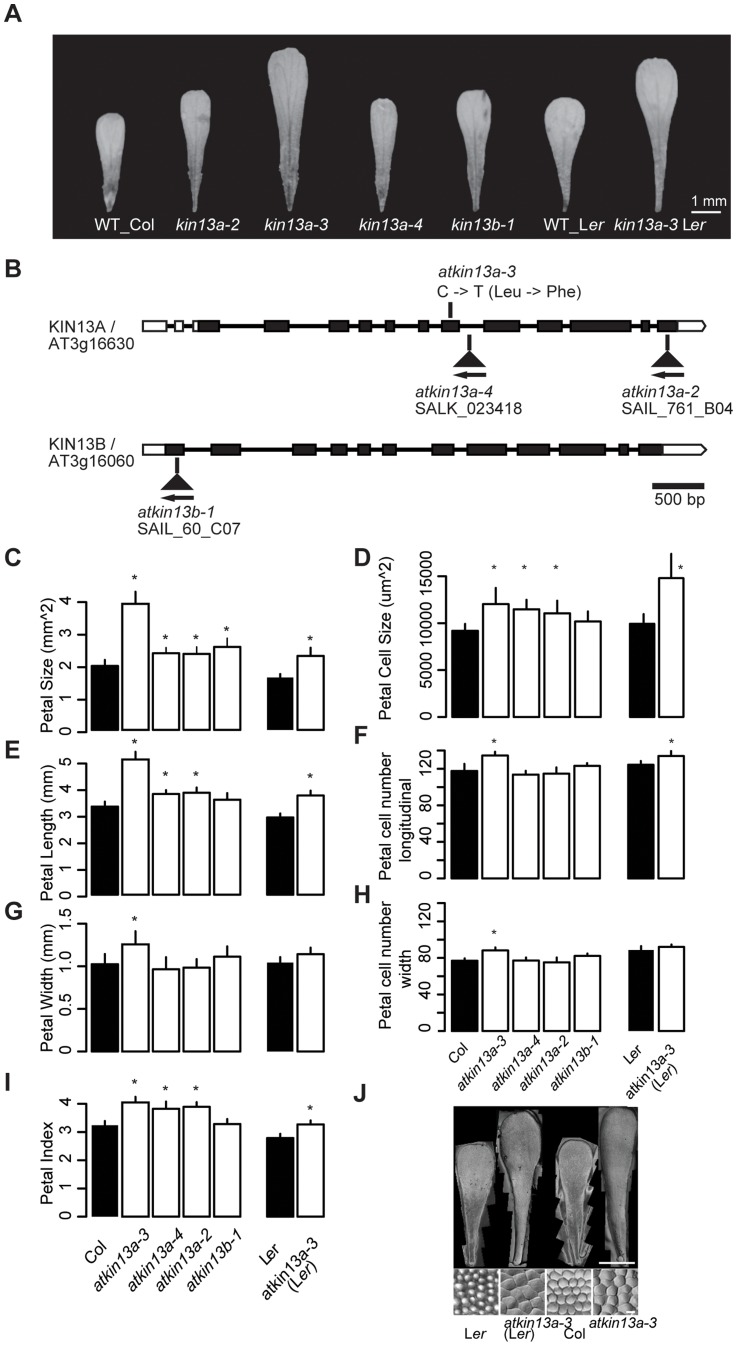
Petal phenotypes of atkin13a and atkin13b loss-of-function mutants.(A) Photographs of petals of the indicated genotypes. Scale bar is 1 mm. (B) Schematic representation of the AtKIN13A and AtKIN13B loci and position of mutant alleles. Open rectangles represent UTRs, filled rectangles show the protein-coding region, and thick connecting lines show introns. (C–I) Measurements of petal parameters for the indicated genotypes. Numbers in C and D indicate relative parameter values with respect to the corresponding wild-type values. Asterisk indicates significant difference from wild-type at p<0.05 (with Bonferroni correction for comparisons to Col-0). (C) Petal size. (D) Petal-cell size. (E) Petal length. (F) Petal cell number in the longitudinal direction. (G) Petal width. (H) Petal cell number along the petal width. (I) Petal index, i.e. length divided by width. (J) Gel prints (top) and representative cells (bottom) from petals of the indicated genotypes. Scale bars are 1 mm (top panel) and 100 µm (bottom panel). Values are mean + SD of 12 petals (C,E–I) or of 50 petal cells each from more than 10 petals (D).